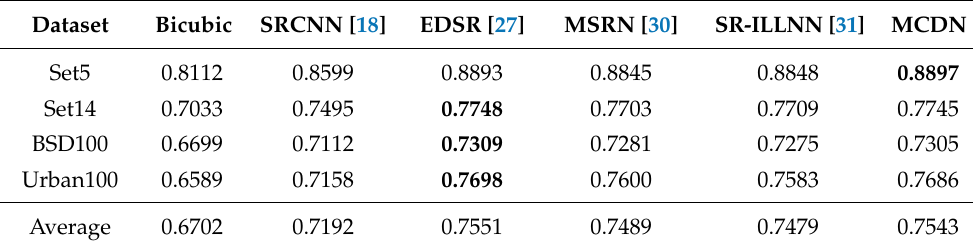
Table 5. Average SSIM on the test datasets. The best results of datasets shown in